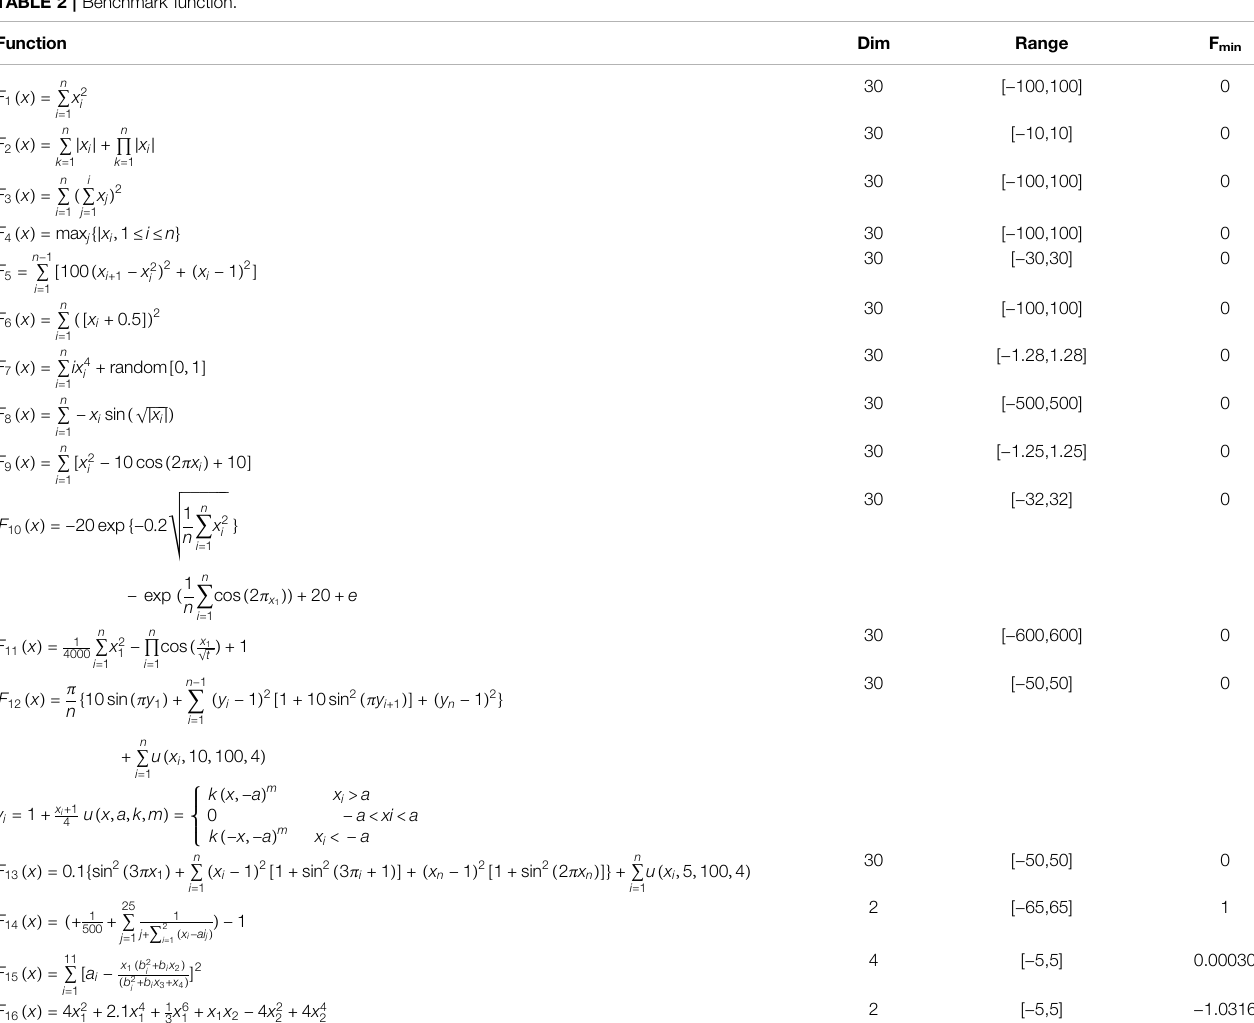
TABLE 2 | Benchmark